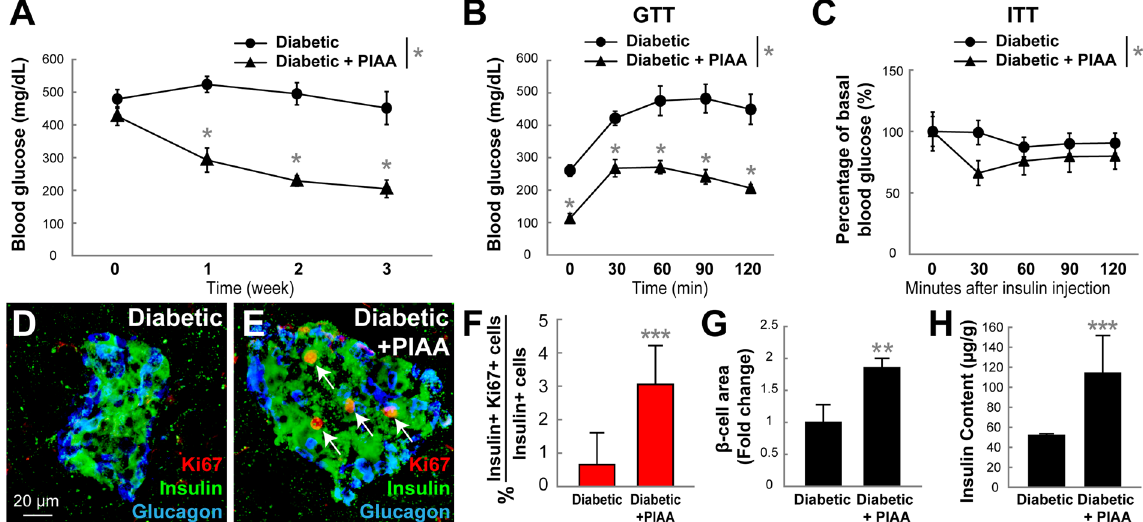
Figure 8. PIAA improves glucose control and β -cell mass in the STZ-induced diabetic mouse model. ( A – H ) STZ-induced diabetic mice were treated with vehicle or PIAA for 2–3 weeks after reaching > 300 mg/dL fed glucose values (n = 6–8 mice per group). ( A ) PIAA caused reduction of hyperglycemia (non-fasting glucose measurement) relative to vehicle-treated animals. PIAA-treated animals showed improved ( B ) glucose and ( C ) insulin tolerance. Confocal images of diabetic pancreata treated with ( D ) vehicle and ( E ) PIAA, respectively, stained for Ki67 (red, white arrows), Insulin (green), and Glucagon (blue). ( F ) The percentage (mean ± SD) of Ki67 and Insulin-double positive cells in diabetic islets increased with PIAA treatment (0.7 ± 1.0% (vehicle) and 3.1 ± 1.2% (PIAA)). Quantification (mean ± SD) of ( G ) β -cell area (fold change, 1.0 ± 0.3 (vehicle) and 1.9 ± 0.1 (PIAA)) and ( H ) insulin content (51.8 ± 1.9 μ g/g (vehicle) and 114.0 ± 37.7 μ g/g (PIAA)) in diabetic pancreata treated with vehicle or PIAA. * P < 0.05; ** P < 0.01; *** P <